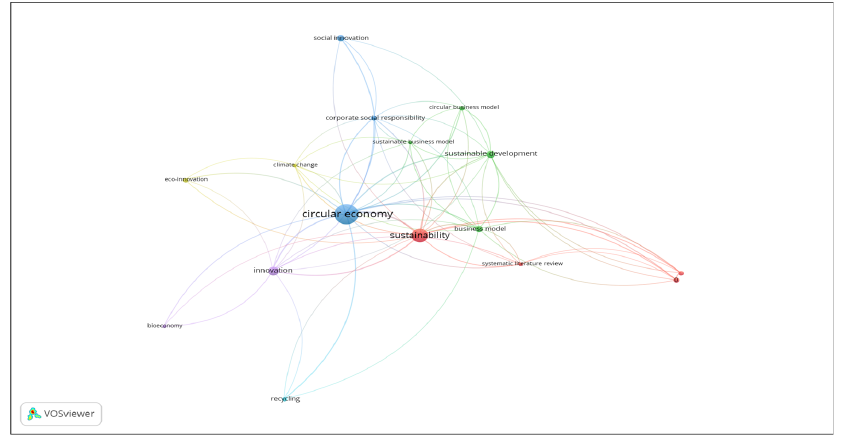
Figure 10. VOSviewer diagram containing the most important author keywords for the couple: social innovation and circular*.